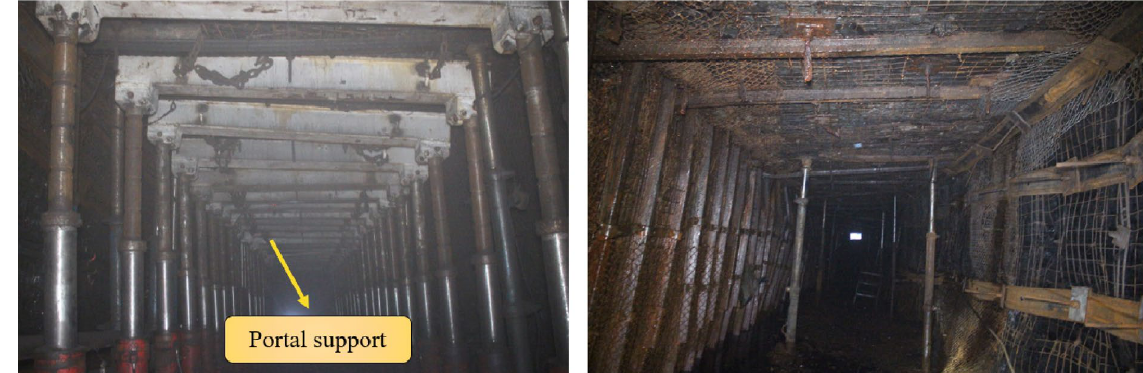
Figure 20. Application effects of the ARFRC method in the affected areas of the geologic faults and the 8# coal